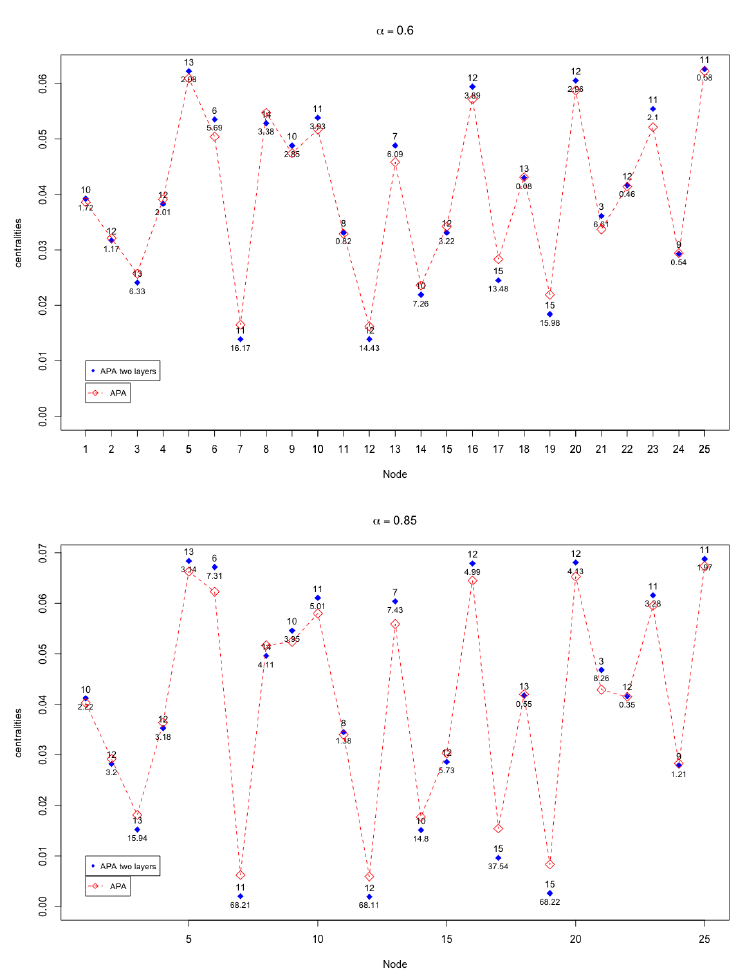
Figure 3. APA and APA2f centralities for the graph represented in Figure 2.